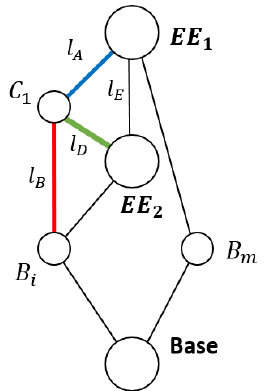
cable with Figure 4 . Graphical simplified representation of robot topology. The red line is the Figure 4. Graphical simplified representation of robot topology. The red line is the l B cable with imposed tension exerted by the actuator; the green line is that transmits effort to the second end imposed tension exerted by the actuator; the green line is l D that transmits effort to the second end 𝑙𝑙 𝐵𝐵 represents the linear sensor link. effector and the blue line effector and the blue line l A represents the linear sensor 𝑙𝑙 𝐷𝐷 𝑙𝑙 𝐴𝐴